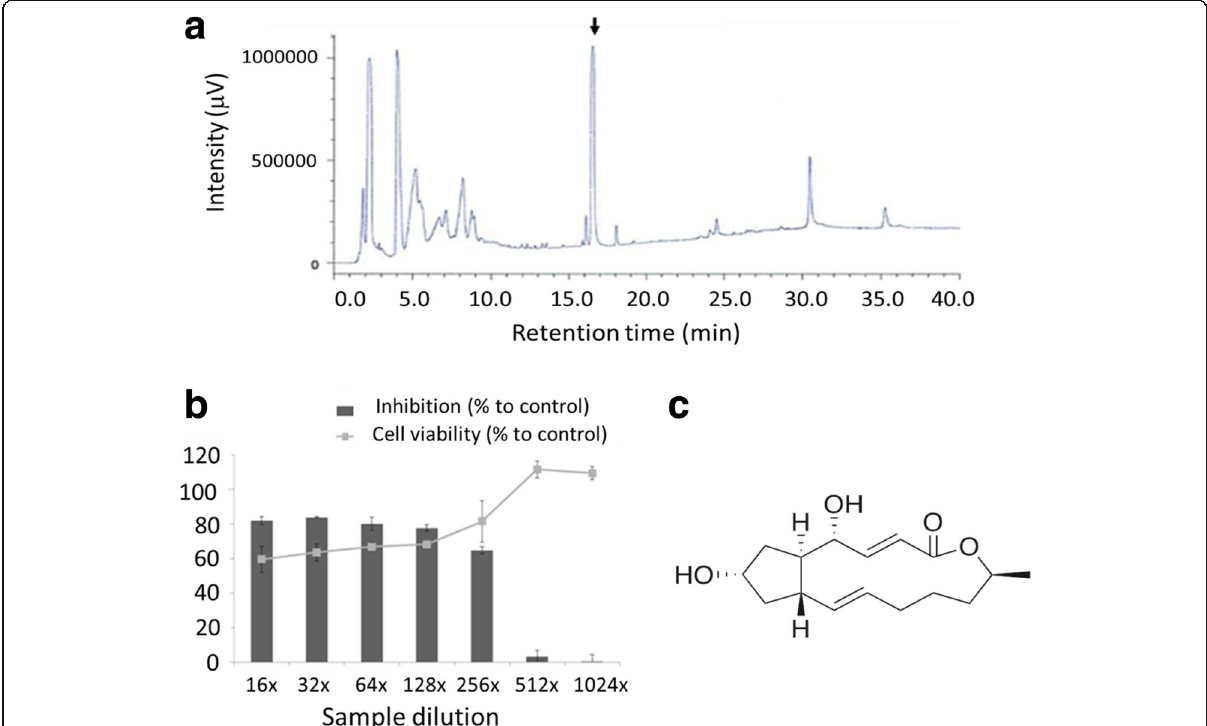
Fig. 1 Identification of brefeldin A as DENV inhibitor. a Fractions of aqueous residue of cultured broth were applied to HPLC. HPLC chromatogram is shown, whereas peak of active molecule (fraction #17) was indicated with an arrow. b Vero cells in 96-well plates were infected with DENV at an MOI of 0.03 in the presence of fraction #17 with increasing dilutions. The cells were incubated for 5 days at 37 °C in 5% CO 2 after which ICFs were harvested and subjected for antigen detection ELISA. In separated experiments, Vero cells in 96-well plates were treated with the fractions with increasing dilutions without virus infection. After 5 days incubation, cell viability was determined by MTT assay as described in the “ Materials and methods ” section. The error bars represent standard deviation from the means of the results from triplicate determination. c By HR-ESI-MS and NMR methods, the fraction #17 was identified as brefeldin A. Structural formula of BFA is